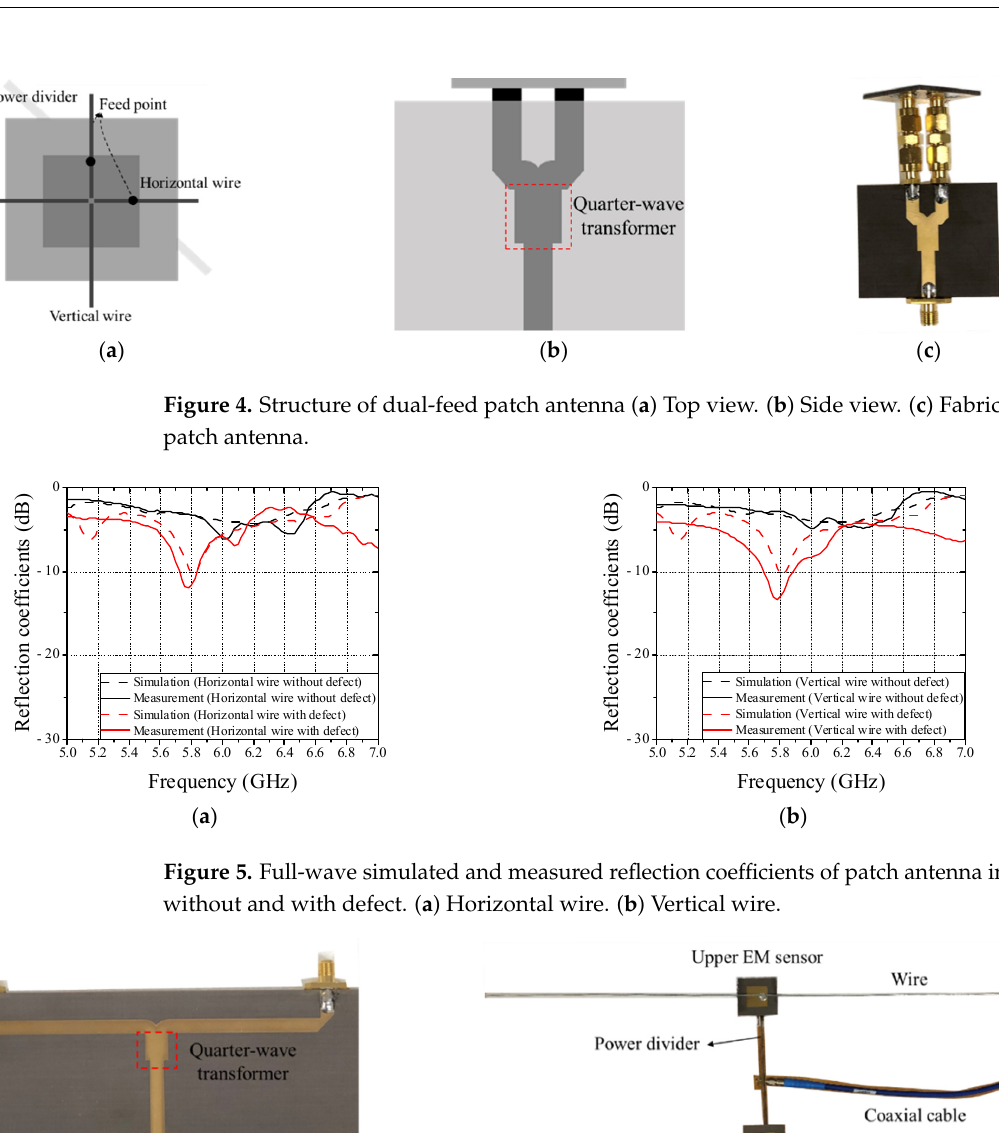
Sensors 2022 , 22 , x FOR PEER REVIEW 7 of 12